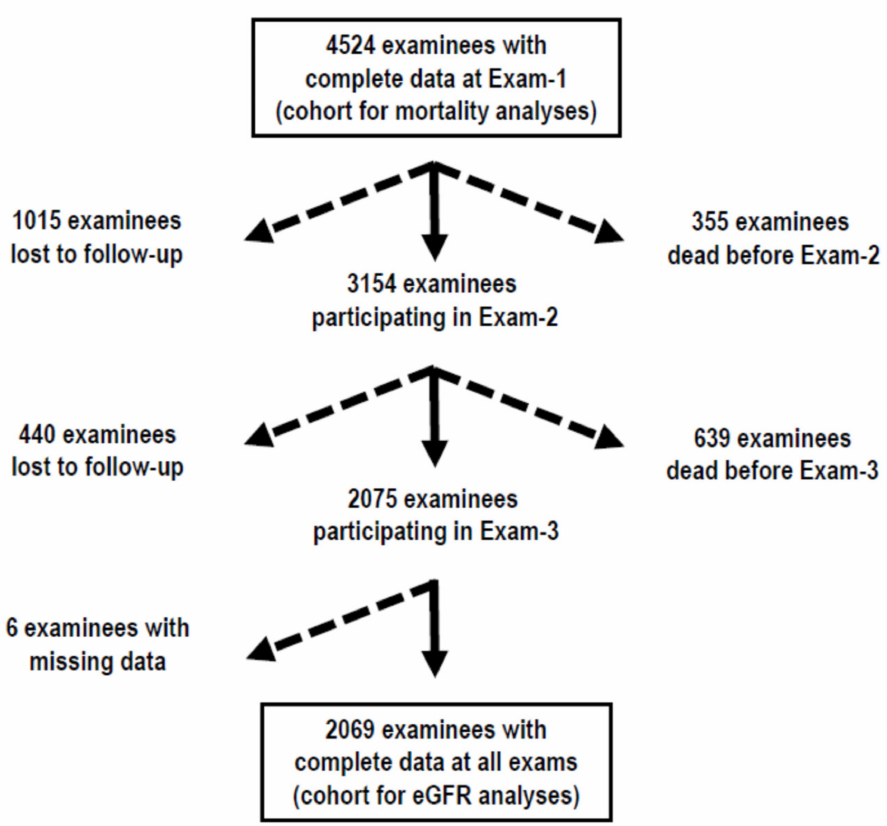
Figure 1. Examinees participating in each exam, examinees lost to follow-up, and dead examinees. Table 1 report descriptive statistics on sex, age, alcohol intake, eGFR, and covariates in the 2069 examinees with complete data at the three exams. Urinary albumin/creatinine ratio was measured only at Exam-2 in examinees with age 45–64 years (mg/g: median = 6.0, IQR =